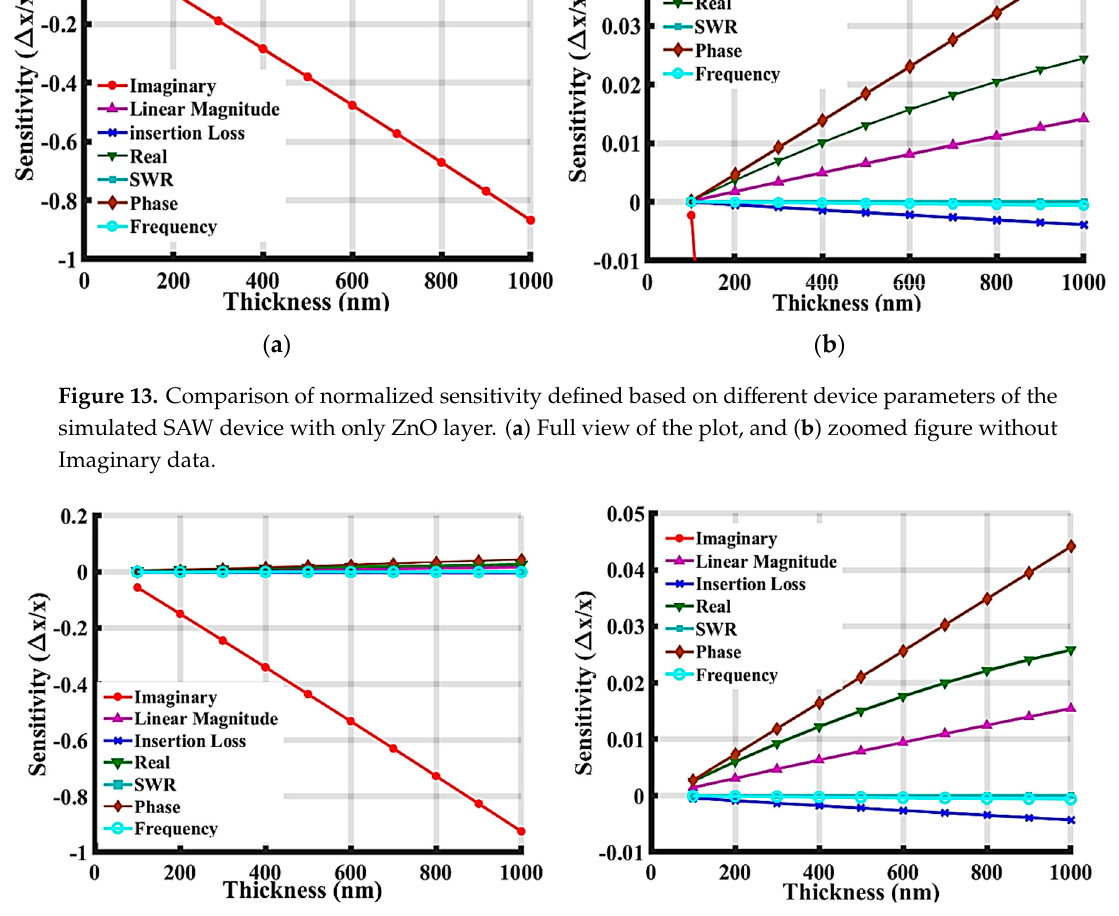
Figure 15. The frequency sensitivity comparison between a SAW-based device with only varying ZnO layer and a device with 50 nm IrO 2 layer on top of the varying ZnO layer. ( a ) ( b ) Figure 16. Simulation results of the SAW device with a 300 nm ZnO layer and an extra coating IrO 2 layer of varied thickness from 10nm to 80nm. ( a ) Full view of the plot, and ( b ) zoomed figure without Imaginary data.